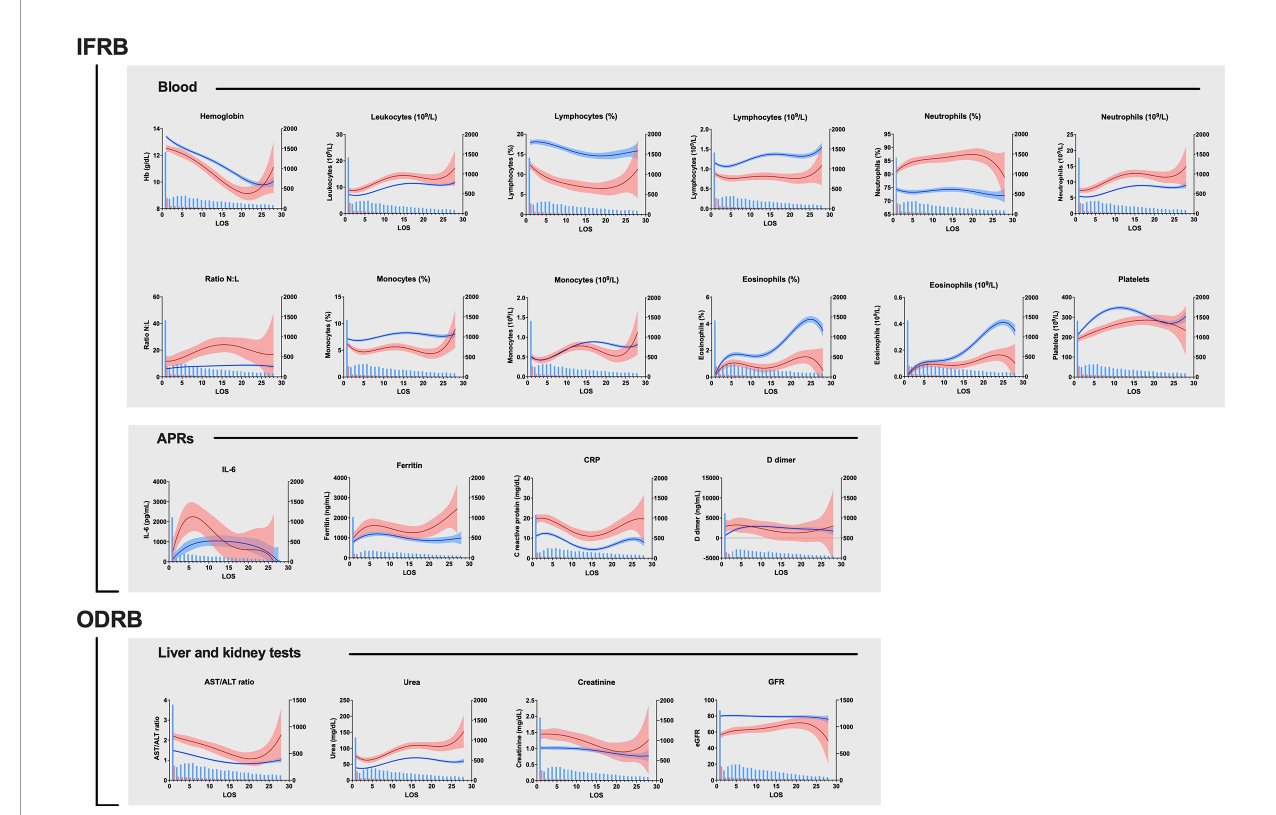
FIGURE 6 | Vall d ’ Hebron University Hospital cohort, variations in the average clinical laboratory variables during the 28-day follow-up period. The blue and red lines represent the mean ± CI values of the parameter for each day of follow-up for the survivors and deceased respectively. The blue bars indicate the number of values available for each day. Notice that samples were not obtained every day and therefore the averages result from plotting together all available values for each day of follow-up, as in 4. Data correspond to 7,586 samples, 6,589 from survivors and 997 from deceased out of 1,079 patients of the HUVH cohort. NLR, neutrophil-to- lymphocyte ratio; CRP, C-reactive protein; AST, aspartate aminotransferase; ALT, alanine aminotransferase; GFR, glomerular fi ltration rate; IFRB, in fl ammation-related biomarkers, ODBRs, organ damage-related biomarkers. APRs, acute-phase